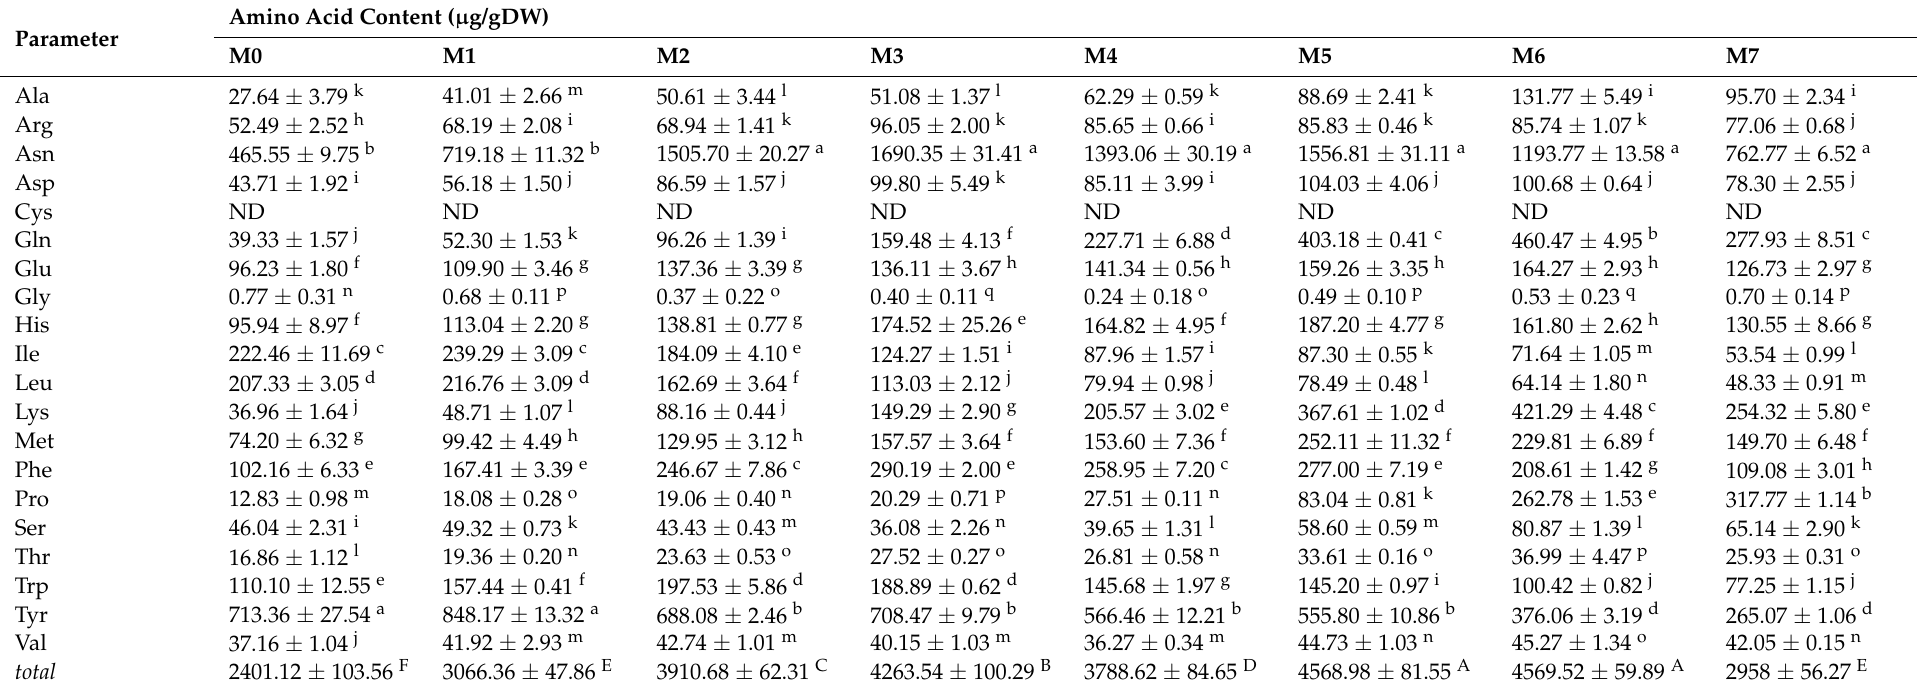
Table 4. Changes in amino acid contents in mulberry fruit during ripening